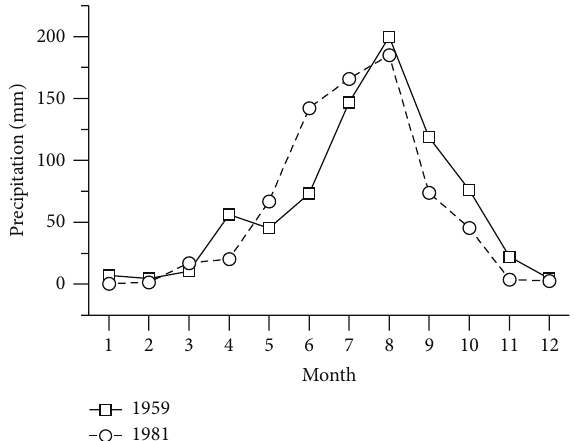
Figure 5: Annual precipitation distribution in Caizuizi Station in 1951 and 1981.